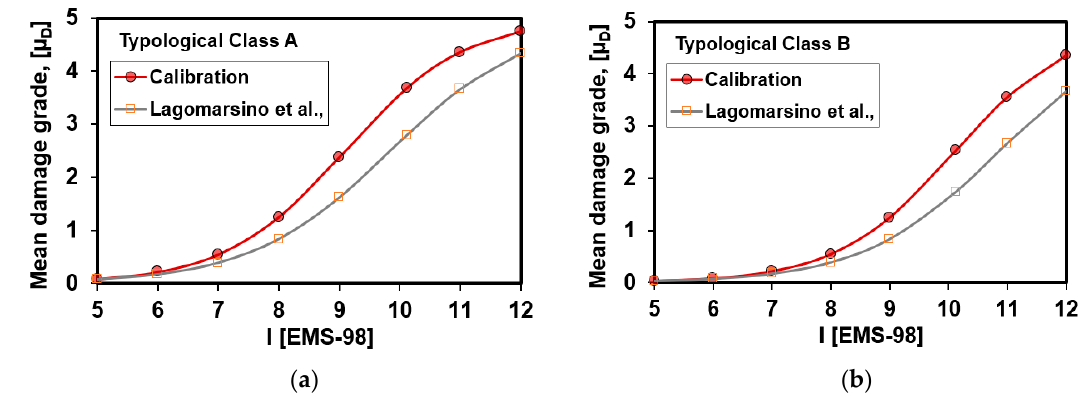
Figure 18. Comparison between the proposed curves and those derived from the macroseismic method proposed by Lagomarsino (2006) [33] for typological classes A and B.